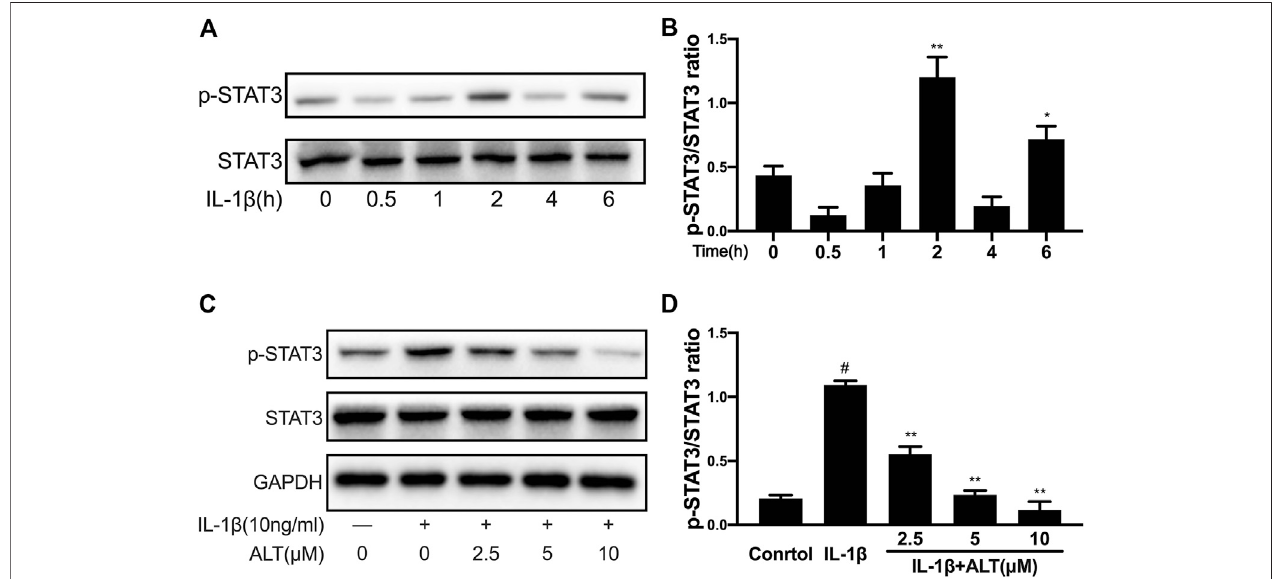
FIGURE 6 | ALT restrained the phosphorylation of STAT3 induced by IL-1 β in mouse chondrocytes. (A) Mouse chondrocytes were exposed to IL-1 β (10 ng/ml) at different time points (0, 0.5, 1, 2, 4, and 6 h). Phosphorylation of STAT3 was determined by Western blot. (B) Relative protein expression was quali fi ed by ImageJ software, STAT3 was used as the internal control ( n (cid:2) 3). (C) Cells were treated by ALT (2.5, 5, and 10 μ M) with or without IL-1 β (10 ng/ml) for 2 h. Phosphorylation of STAT3wasdeterminedbyWesternblot. (D) Relativeproteinexpressionwasquali fi edbyImageJsoftware,STAT3wasusedastheloadingcontrol( n (cid:2) 3).# p < 0.05 vs. control group; * p < 0.05 vs. IL-1 β group; ** p < 0.01 vs. IL-1 β